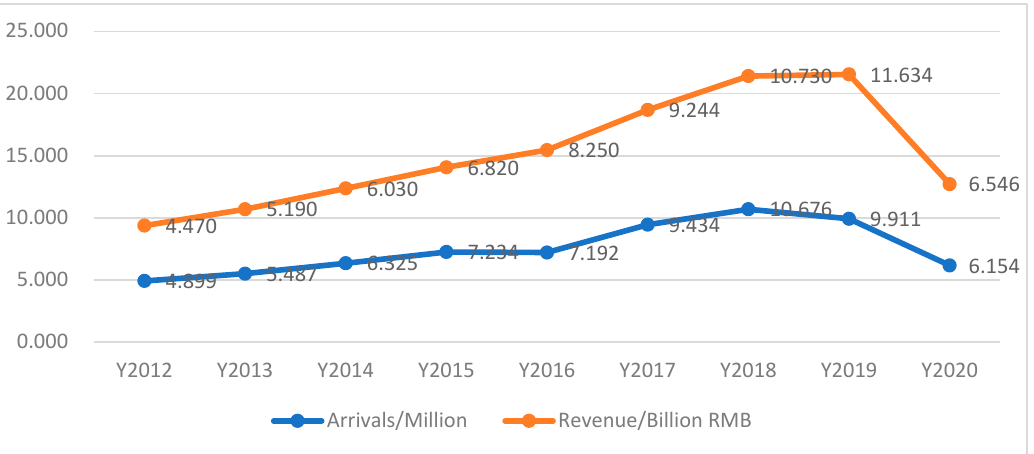
Figure 2. Tourist arrivals and income of tourism industry of Qingzhou, 2012–2020. Source: Statistical Bulletins of National Economic and Social Development of Qingzhou, Statistical Bureau of Qingzhou.